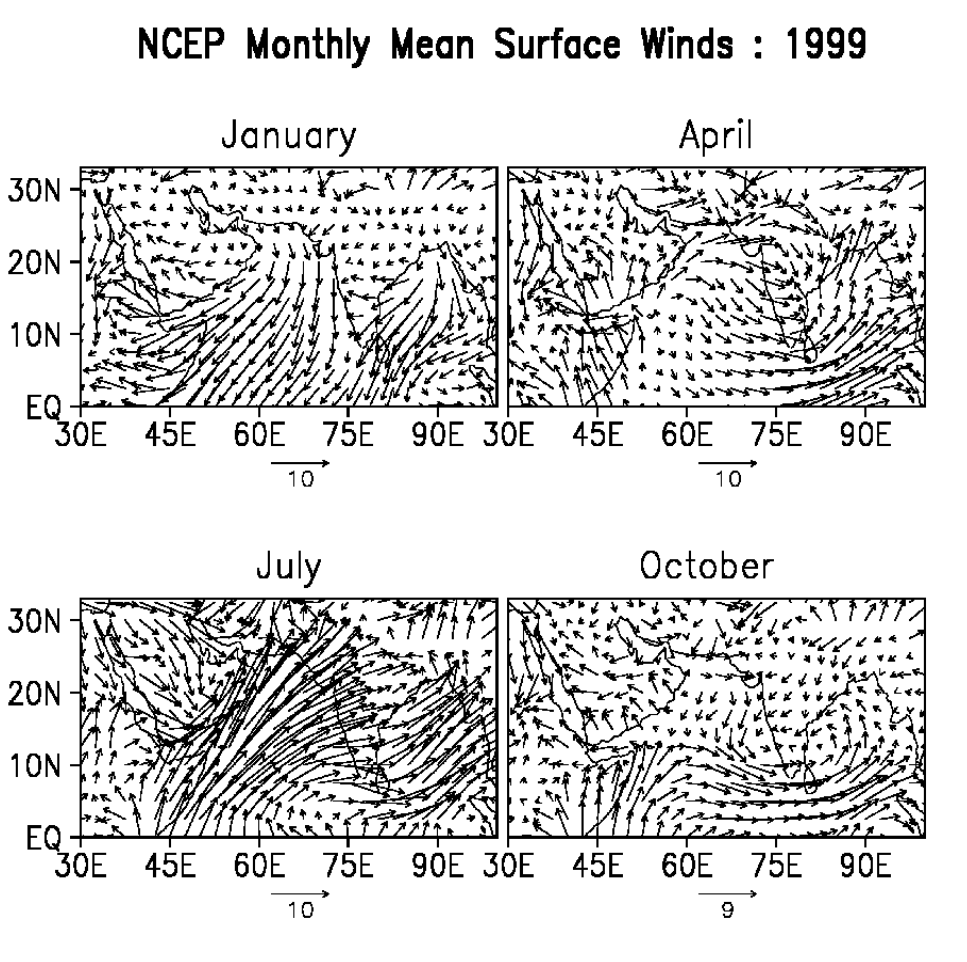
Fig. 12. The monthly regional distribution of surface winds during 1999 over India and adjacent continents for four representative months. The length of the arrows represent the magnitude of wind speed and its direction represents wind